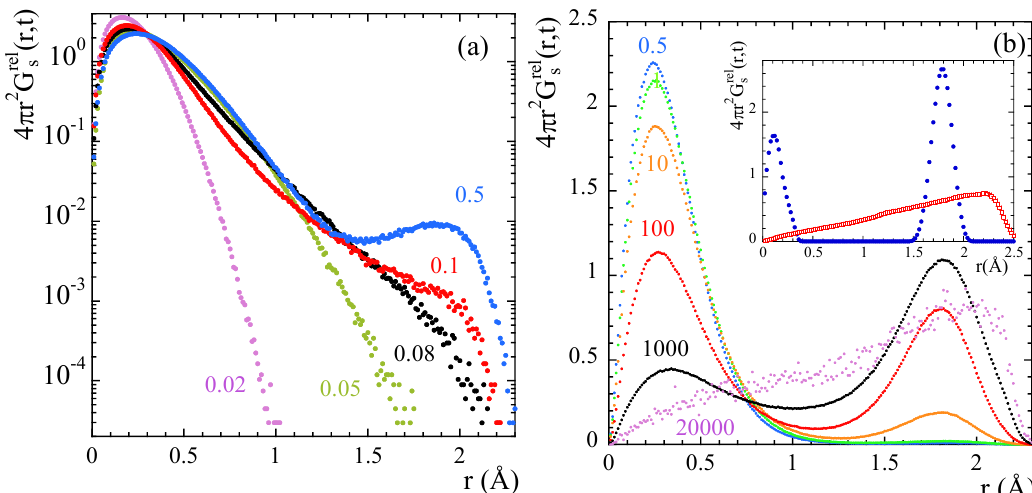
Figure 10. Radial probability distribution function of mH atoms relative to mC at 335 K and different times. Results in ( a ) are plotted in a logarithmic scale to enhance the subtle differences occurring at the short times shown. Inset in ( b ): Radial probability distribution function of mH atoms relative to mC calculated for a (semi-)rigid rotor (blue dots) and the same rotor with varying direction of the axis (red squares) (see